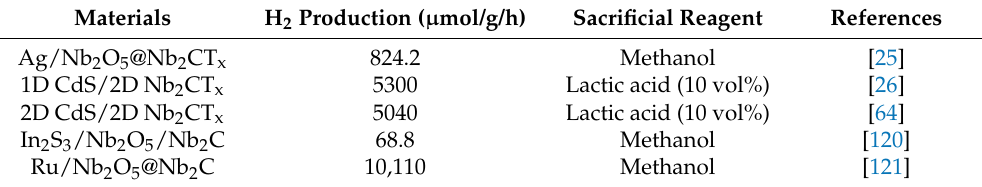
Table 4. The specific capacities of Nb 2 CT x for Photocatalytic H 2